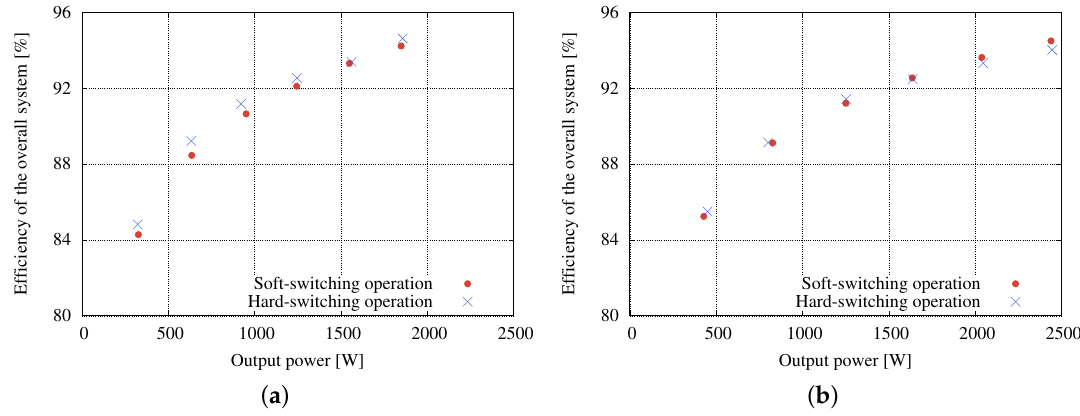
Figure 9. Efficiency of the overall system. ( a ) E 1 = 200 V, E 2 = 150 V; ( b ) E 1 = 200 V, E 2 = 200 V. From the above, the influences on the efficiency of the resonant circuit with the soft-switching